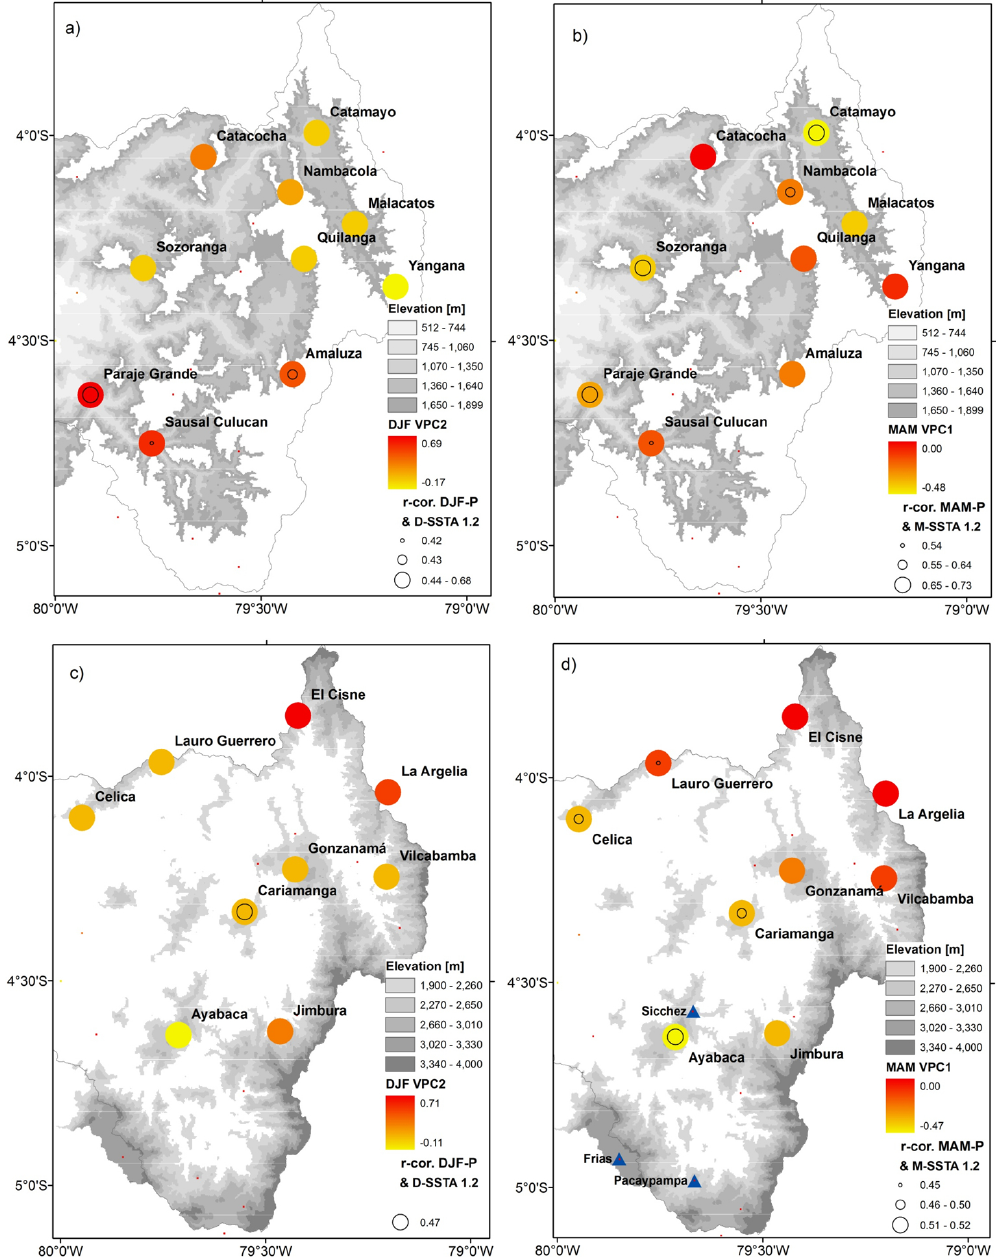
Fig. 3. Loading pattern of seasonal VPC (graded color: red-yellow), and, r-correlation plot of seasonal precipitation with one-month lagged SSTA 1.2 (graded dots) for (a) VPC2 in DJF and middle basin, (b) VPC1 in MAM and middle basin, (c) VPC2 in DJF and upper basin and (d) VPC1 in MAM and upper basin, and, location of stations: Frias, Sicchez and Pacaypamba in the upper basin.